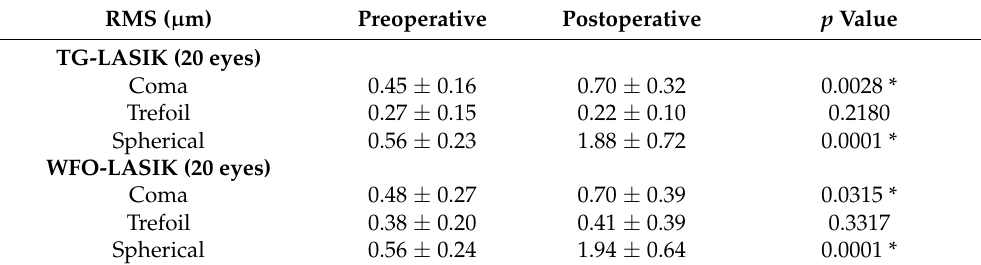
Table 3. Postoperative change in corneal wavefront aberration for the TG and WFO-LASIK groups after 3 months. RMS ( µ m) Preoperative Postoperative p Value TG-LASIK (20 eyes) Coma 0.45 ± 0.16